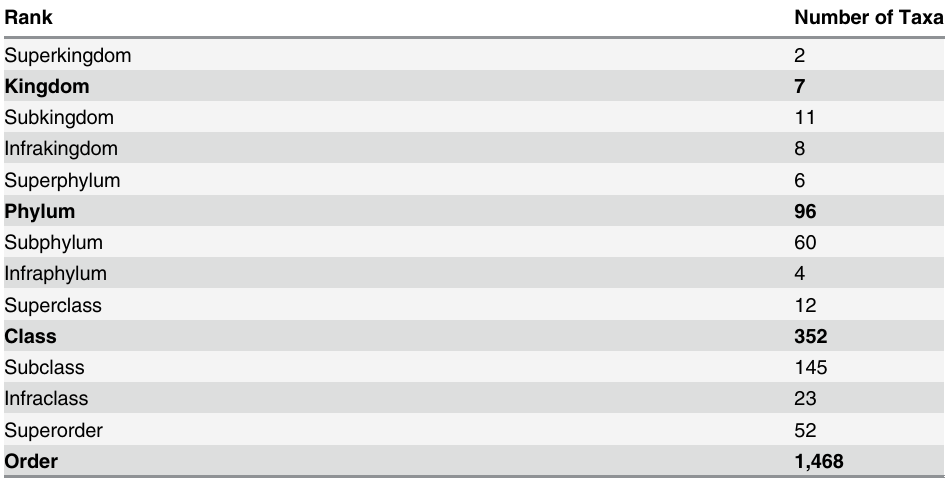
Table 1. List of ranks used in the hierarchy with the number of taxa per rank Rank Number of